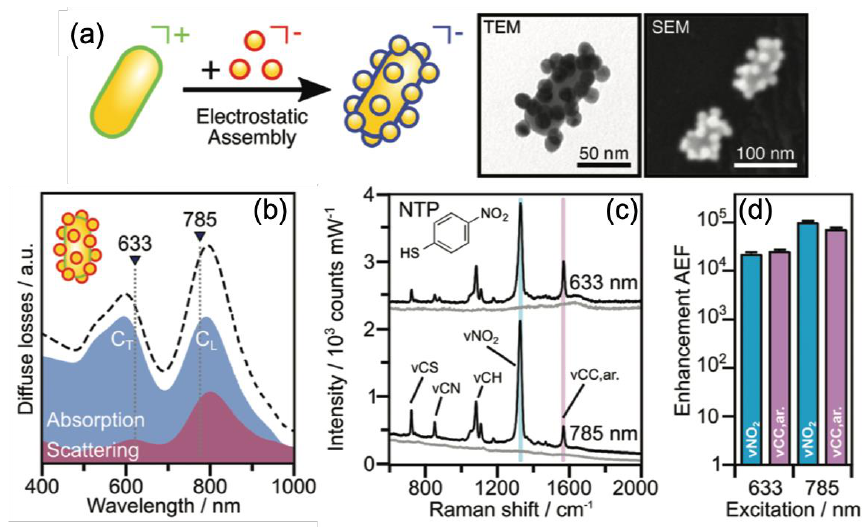
2. Figure 1. ( a ) Scheme of the self-assembly of Au nanospheres on Au nanorods. TEM and SEM images of the obtained superstructures. ( b ) Absorption and scattering spectra of the plasmonic superstructures with the chosen wavelengths of excitation for the transversal (C T ) and longitudinal (C L ) coupled modes, which are 633 nm and 785 nm, respectively. ( c ) SERS spectra of plasmonic superstructures without (in grey) and with 4-NTP molecules (C NTP = 1 µ M, in black) for the two wavelengths of excitation. ( d ) Analytical enhancement factor (AEF) values corresponding to the SERS spectra in ( c ). All the figures are reproduced from [72] with permission from the Royal Society of